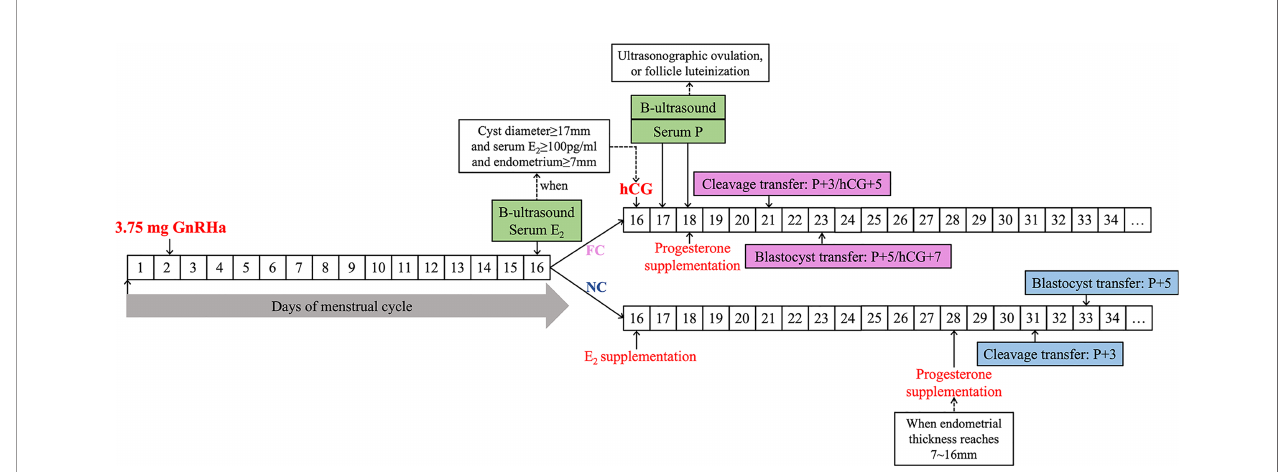
FIGURE 2 | The fl owchart of HRT-FET cycles pretreated with 3.75 mg